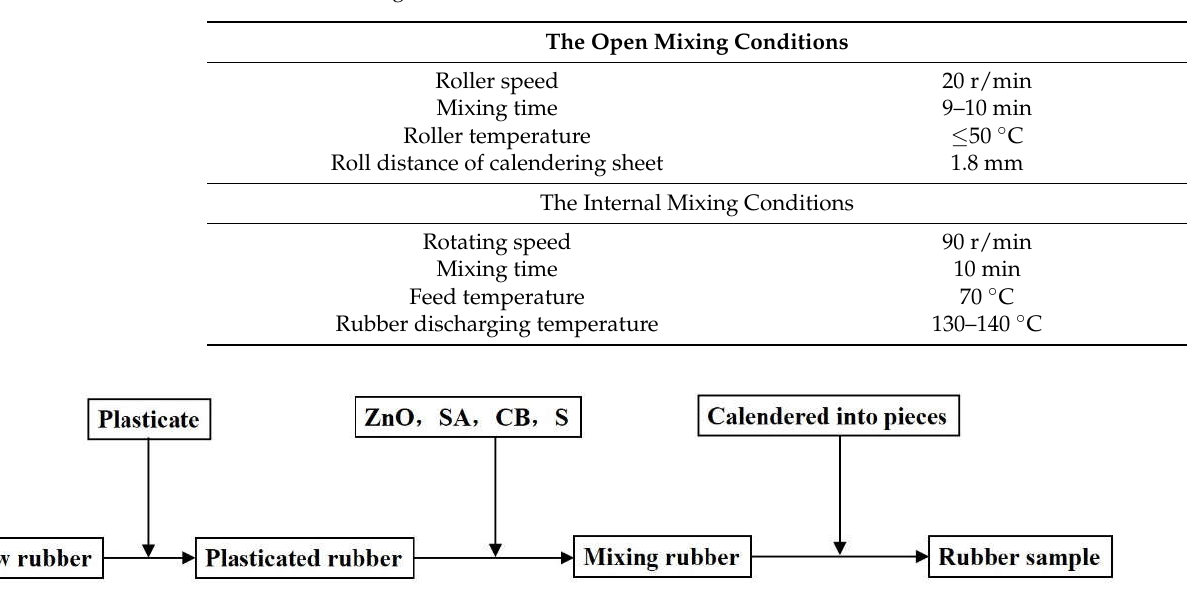
Table 4. The mixing conditions.